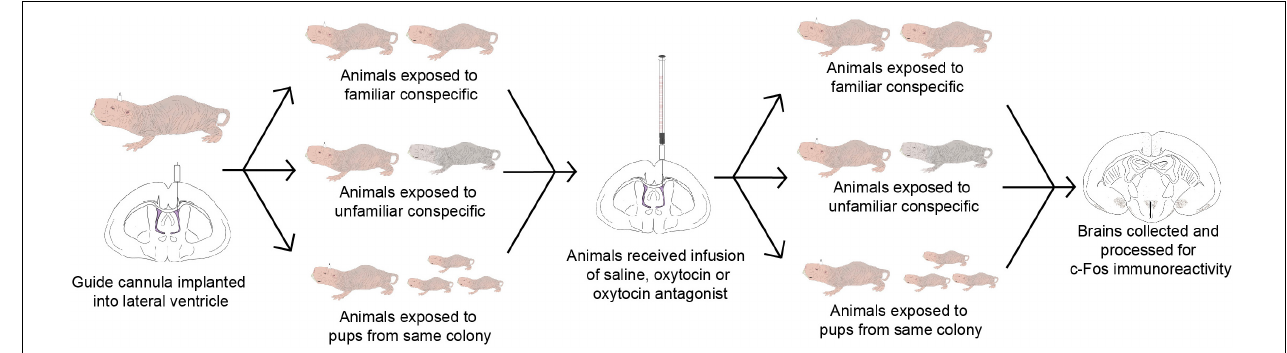
FIGURE 1 | Timeline of the experimental workflow. Animals were implanted with a guide cannula and given 7 days for recovery. On the 8th day, animals were exposed to either a familiar conspecific ( n = 21), an unfamiliar conspecific ( n = 30), or 3 pups from the same colony ( n = 21). On the 9th day, animals were given an infusion of saline, OT, or OTA, and again exposed to either a familiar conspecific ( n = 7 per OT manipulation), unfamiliar conspecific ( n = 10 per OT manipulation), or 3 pups from the same colony ( n = 7 per OT manipulation). Brains were collected 90 min following exposure to stimuli and processed for c-Fos immunoreactivity.